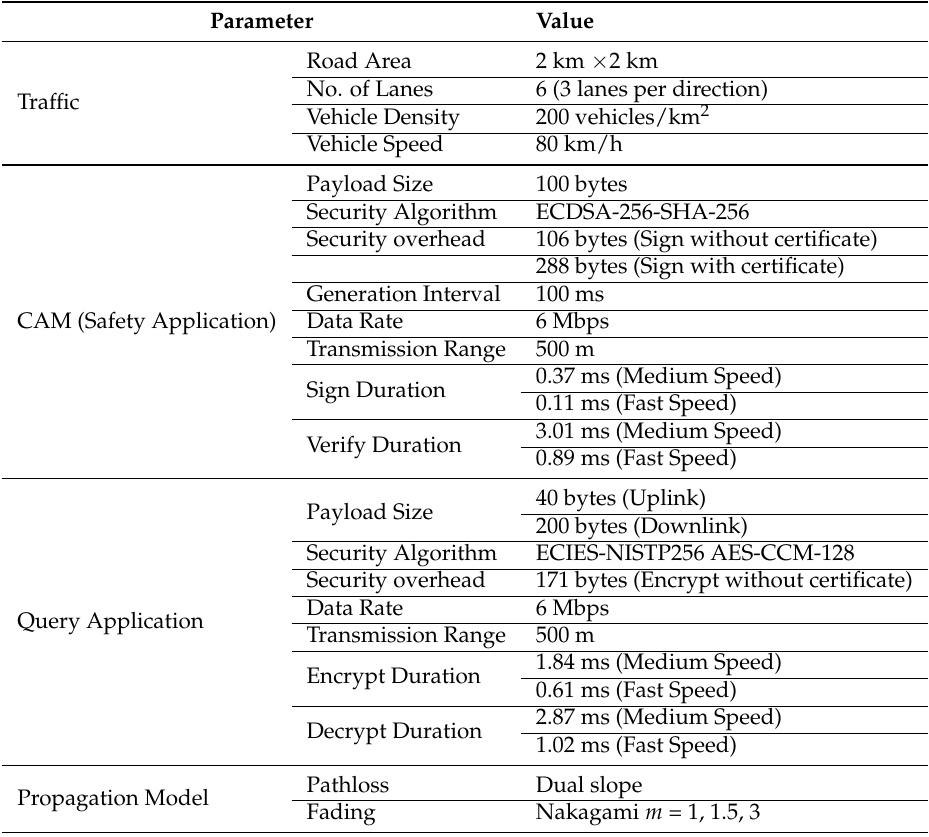
Table 6. Simulation